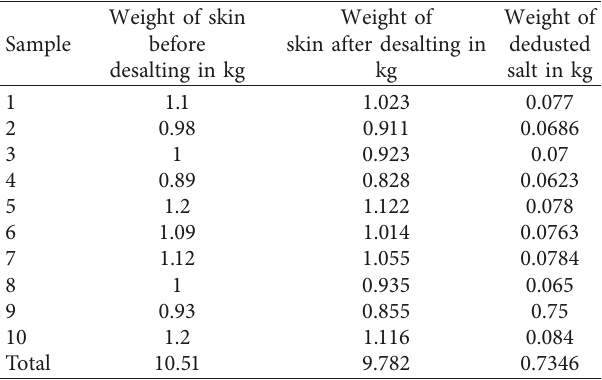
Table 1: The amount of salt recovered and purified from ten cured sheepskins, in case of Bahir Dar Tannery, Ethiopia. Weight of Sample